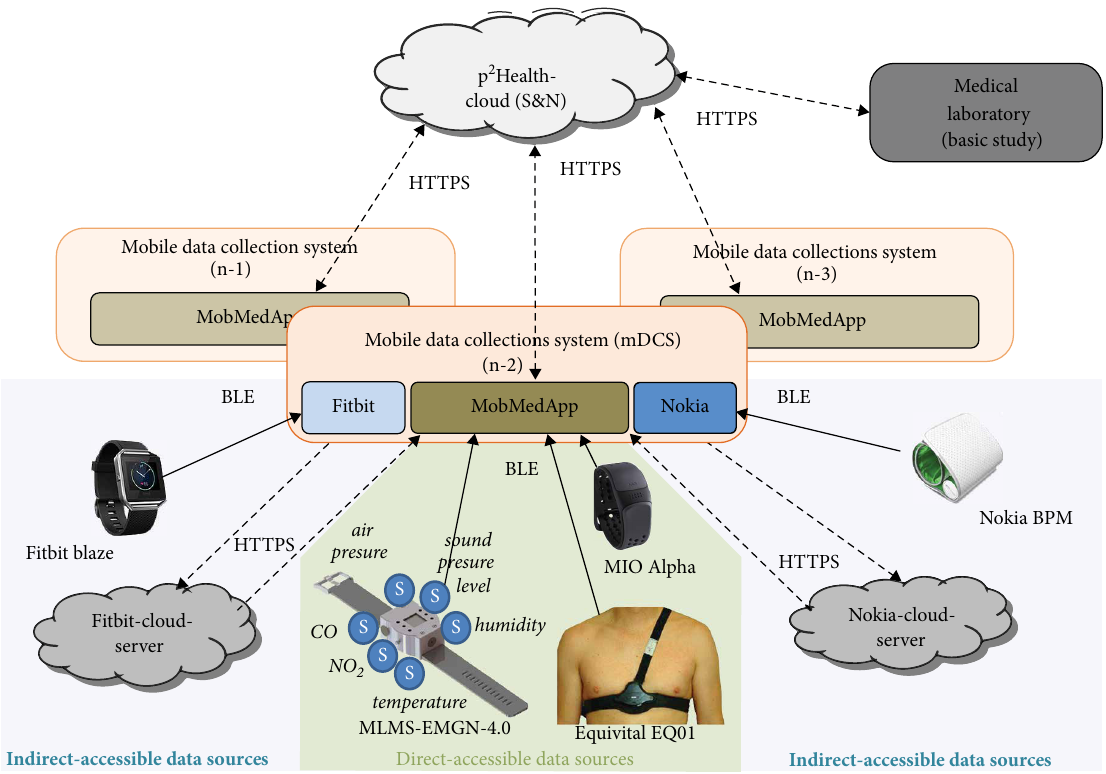
Figure 2: General system structure with focus on the